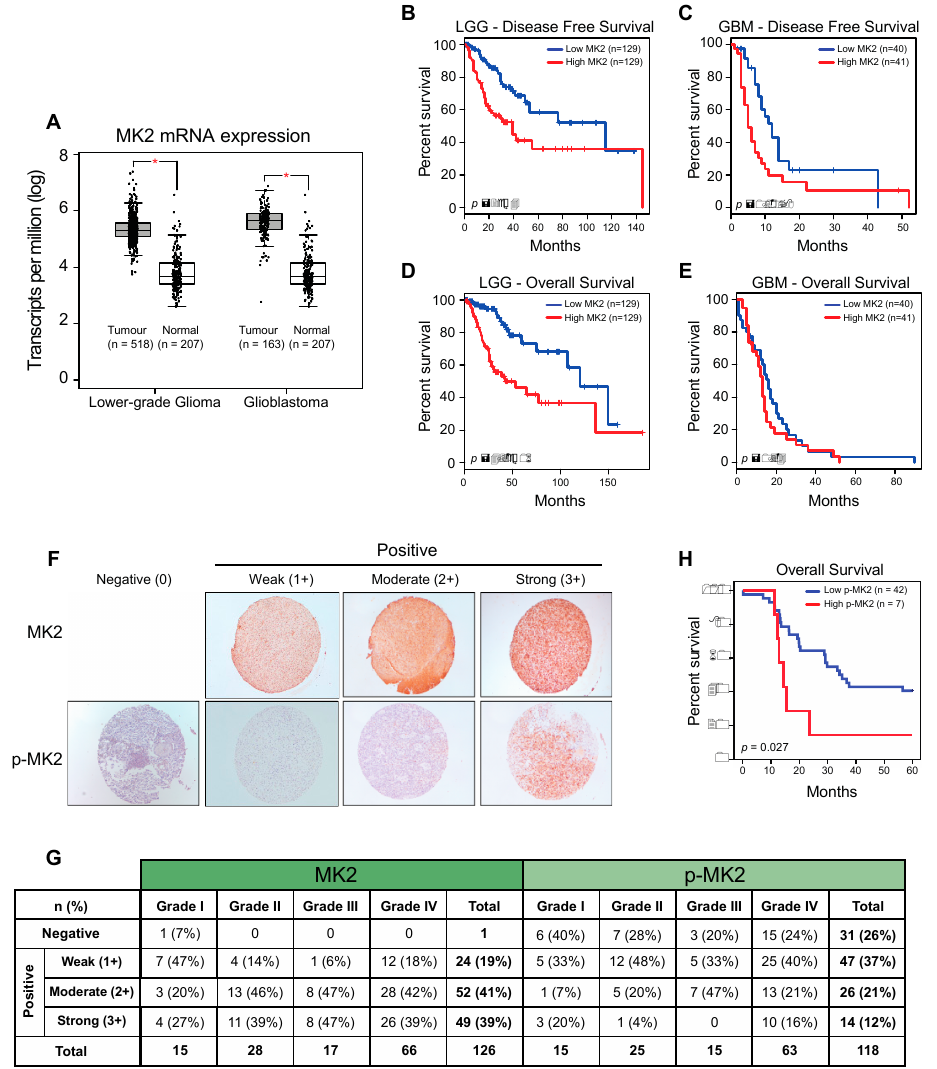
Figure 1. MK2 activity in gliomas correlates with poor prognosis. ( A ) MK2 mRNA expression in lower-grade glioma and glioblastoma compared to normal brain tissue. Figure was generated by GEPIA (mean ± SD, ANOVA, * p < 0.05). ( B–E ) Log-rank survival analysis of lower-grade glioma (LGG) and glioblastoma (GBM) patients based on the MK2 mRNA expression. Figure was generated by GEPIA (low MK2: bottom 25%; high MK2: top 25%). ( F,G ) Representative images and summary of MK2 and p-MK2 immunoreactivity in glioma tissue microarrays. ( H ) Log-rank survival analysis of lower-grade glioma and glioblastoma patients based on the p-MK2 expression (low p-MK2: 0, 1+, 2+ scores; high p-MK2: 3+ score).